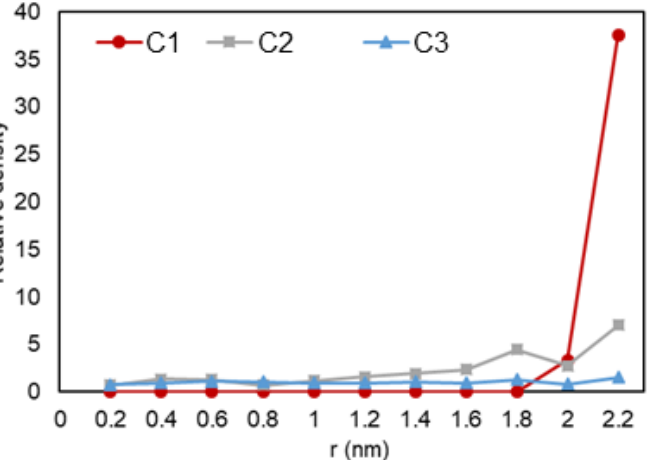
Figure 6. Ethane relative density (mass density inside the pore over the density of the phase in bulk conditions) vs. radial position in C1 (gas phase in bulk), C2 (two-phase in bulk), and C3 (liquid phase in bulk) conditions.